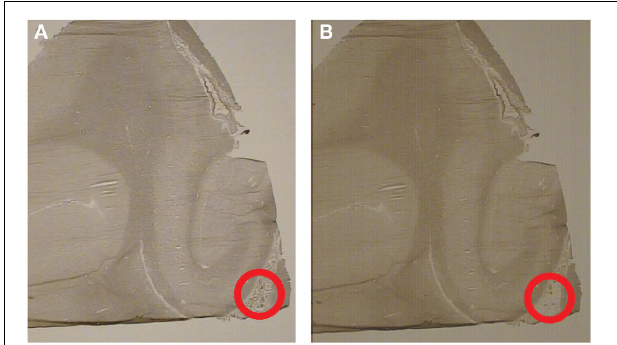
FIGURE 2 | Laser-capture microscopy images from the same subject before and after capture. Representative images from the laser capture microscope (4X). The hippocampus is to the left and the choroid plexus within the lateral ventricle is located inside the circle. (A) Representative image of the choroid plexus before laser capture. (B) Representative image of the choroid plexus after laser capture. Notice that the choroid plexus has been removed from the area inside the circle.